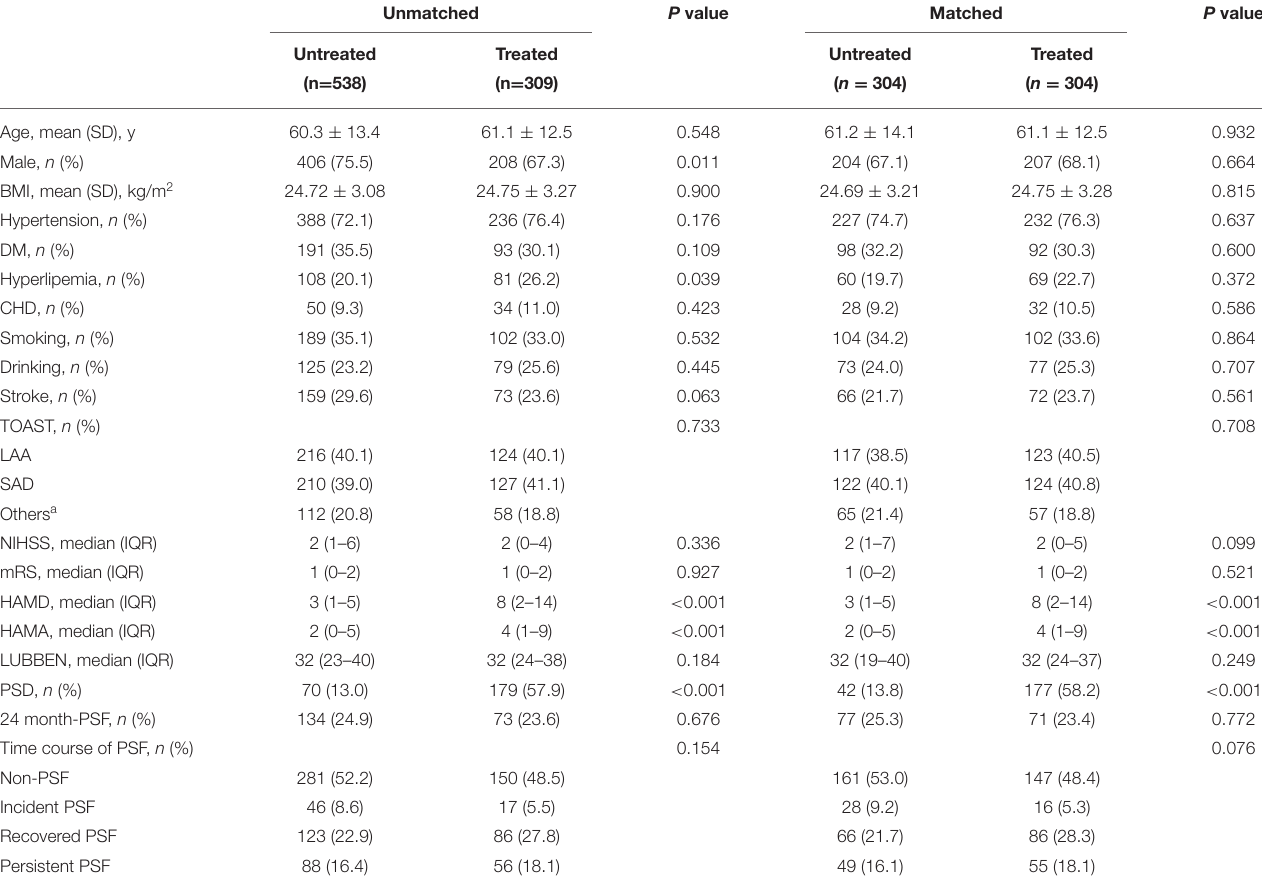
TABLE 1 | Comparison of the baseline characteristics and neuropsychological scores between unmatched and propensity score-matched groups. Unmatched P value Matched P value Untreated Treated